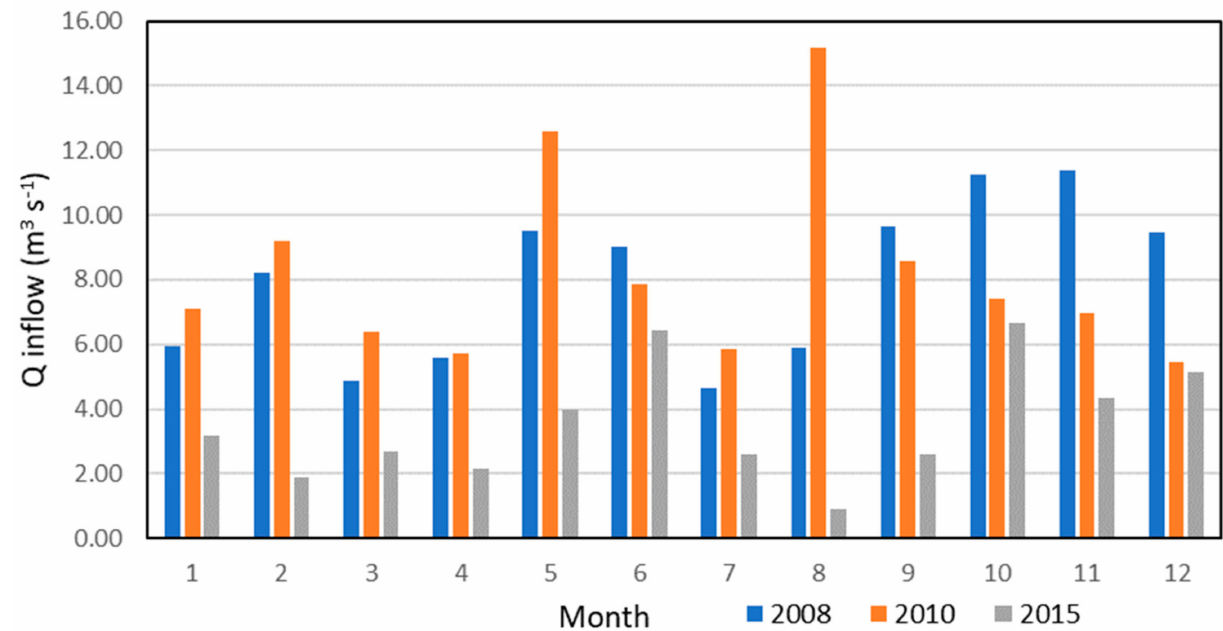
Figure 3. Average inflow in each month, estimated in three different years: 2008 (moist year), 2010 (intermediate) and 2015 (dry